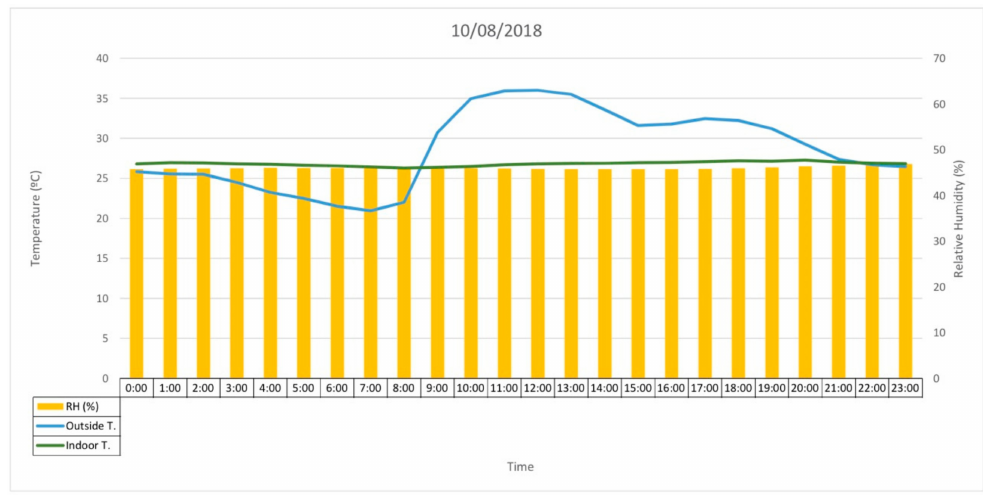
Figure 22. Hourly evolution of temperature and relative humidity after refurbishment in a random summer